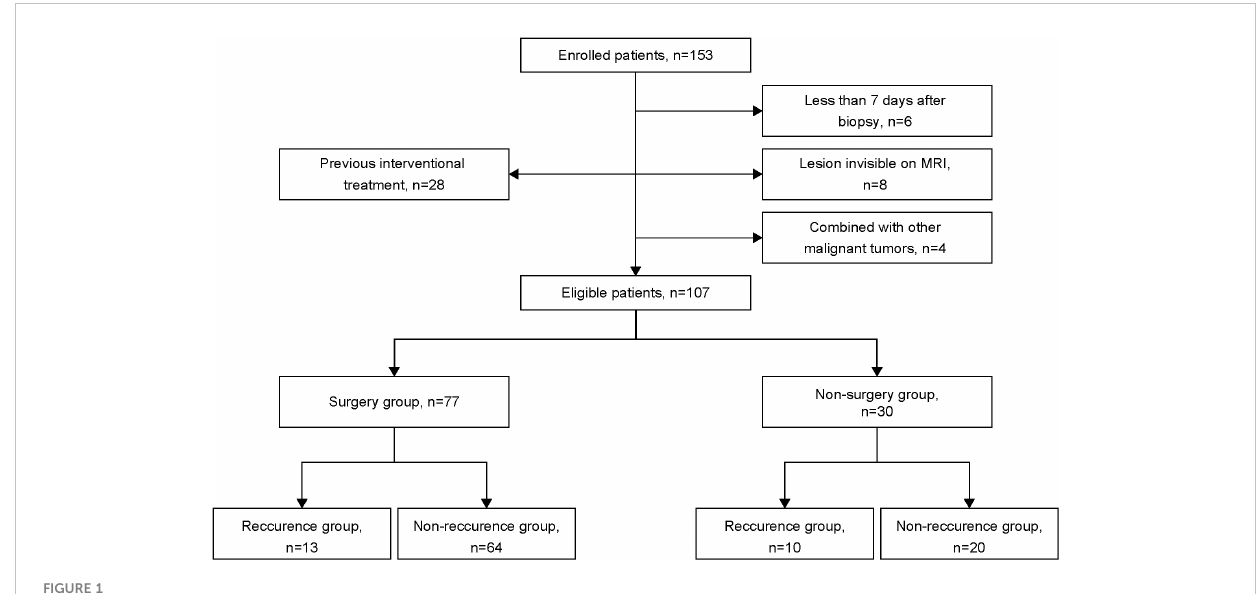
FIGURE 1 Flowchart of patient